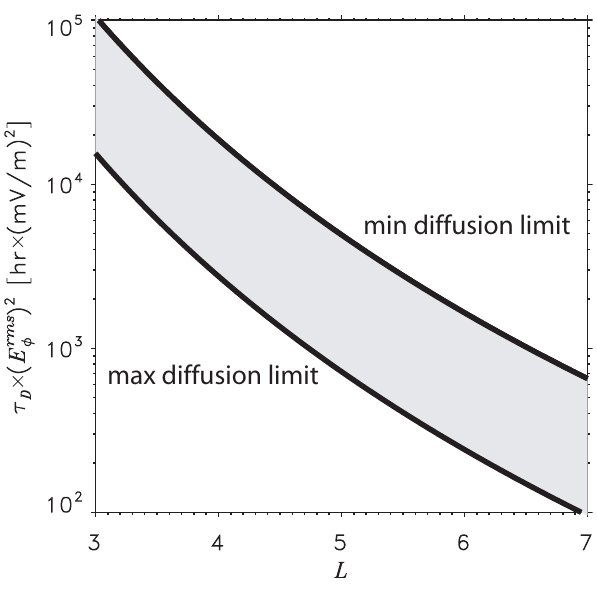
Fig. 4. Characteristic timescales of radial transport due to stormtime Pc5s normalized to the root-mean-square amplitude of the wave electric